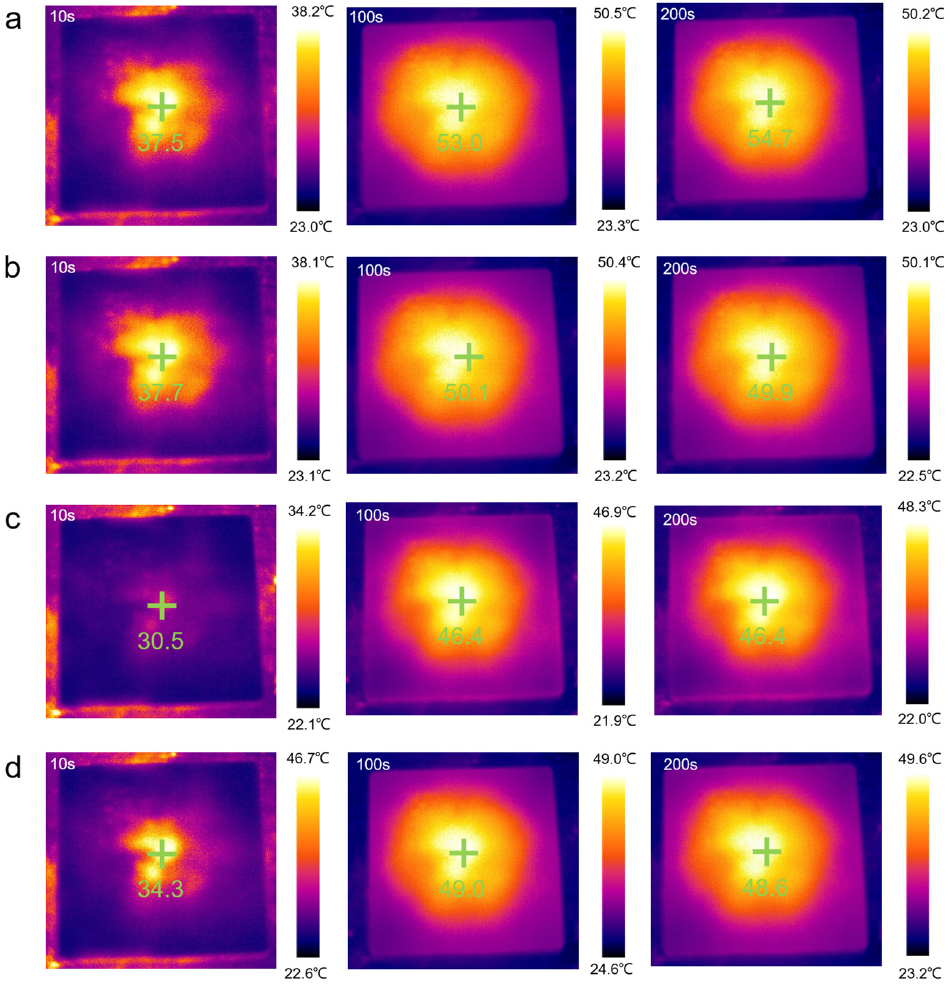
Figure 9. Thermal imaging camera results of the ( a ) PEG/WF, ( b ) PEG/WF/9.0APP@1.0OMMT, ( c ) PEG/WF/8.0APP@2.0OMMT and ( d ) PEG/WF/6.0APP@4.0OMMT composites.